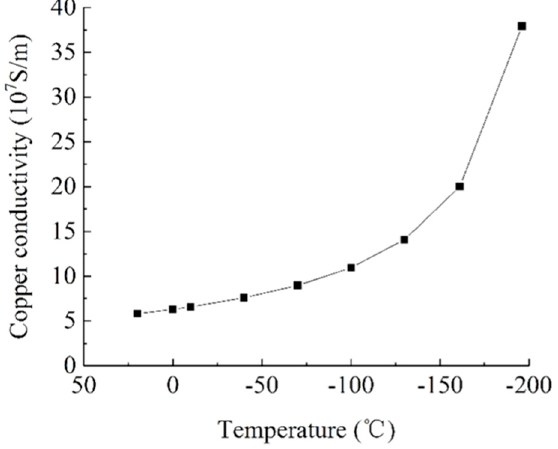
Figure 16. Variation diagram of copper conductivity with temperature.